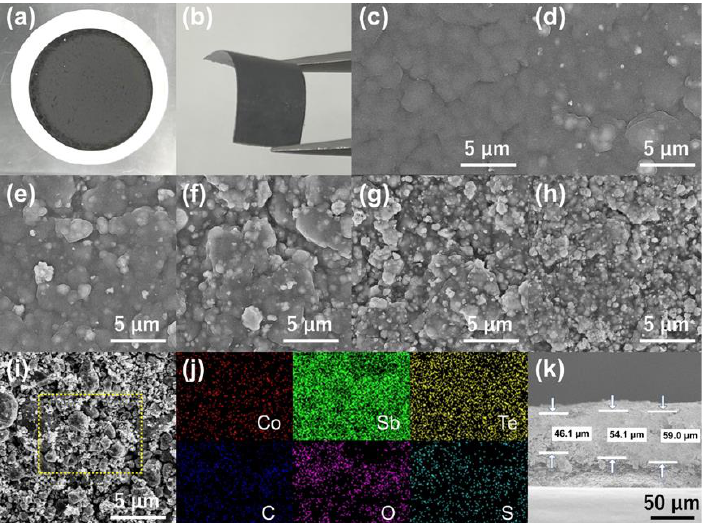
Figure 1. ( a , b ) The digital photo images of the 98 wt% CoSb 2.95 Te 0.05 /PEDOT:PSS hybrid film; SEM images of ( c ) pristine PEDOT:PSS ‐ 5% DMSO, ( d ) 20 wt%, ( e ) 40 wt%, ( f ) 60 wt%, ( g ) 80 wt%, ( h ) 90 wt% and ( i ) 98 wt% CoSb 2.95 Te 0.05 hybrid film; ( j ) the corresponding EDX mapping images of Co, Sb, Te, C, O, and S; and ( k ) cross ‐ sectional SEM image of the 98 wt% CoSb 2.95 Te 0.05 hybrid film.